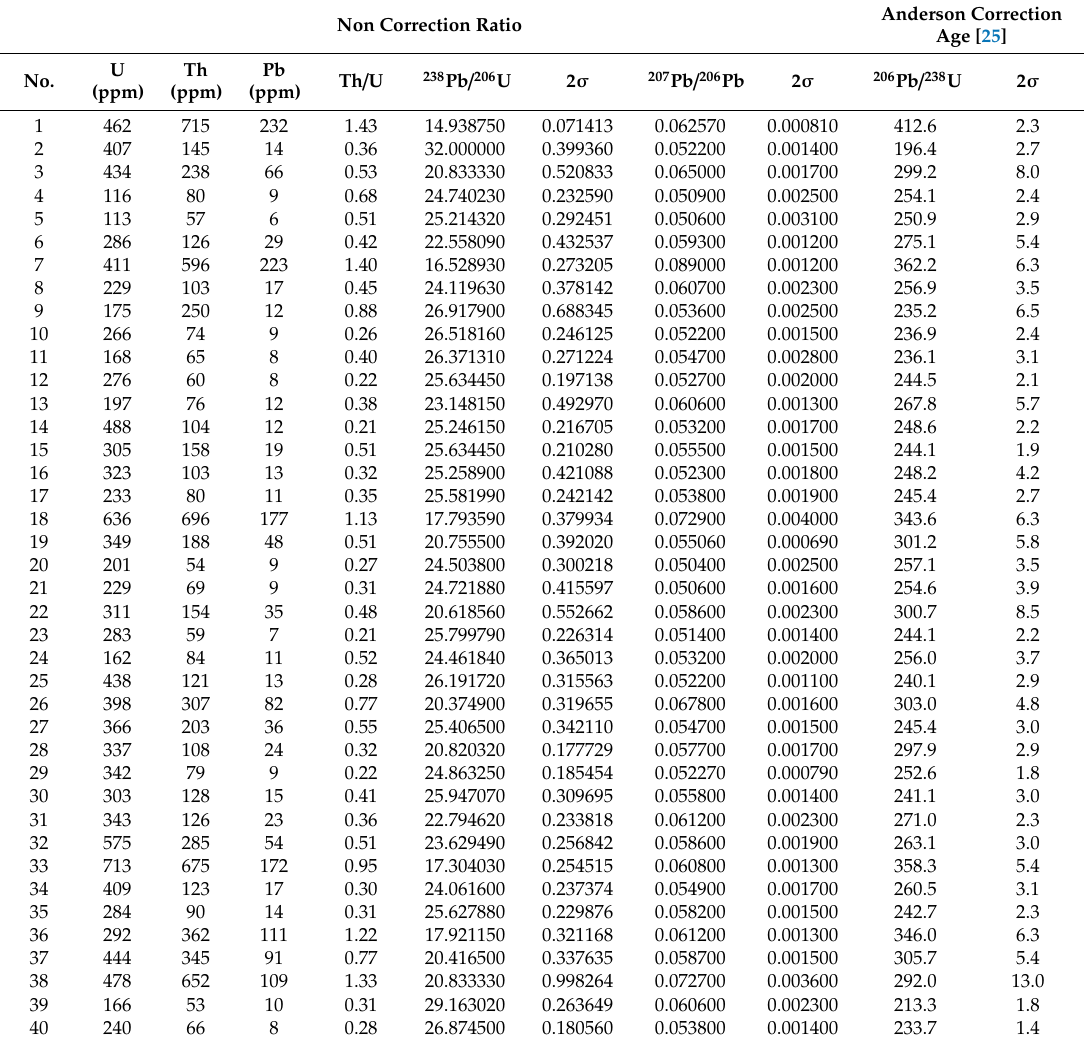
Table 1. Laser ablation multi-collector inductively coupled plasma mass spectrometry (LA-MC-ICP-MS) U–Pb–Th isotopic analytical data for zircon from the quartz–allanite vein. Non Correction